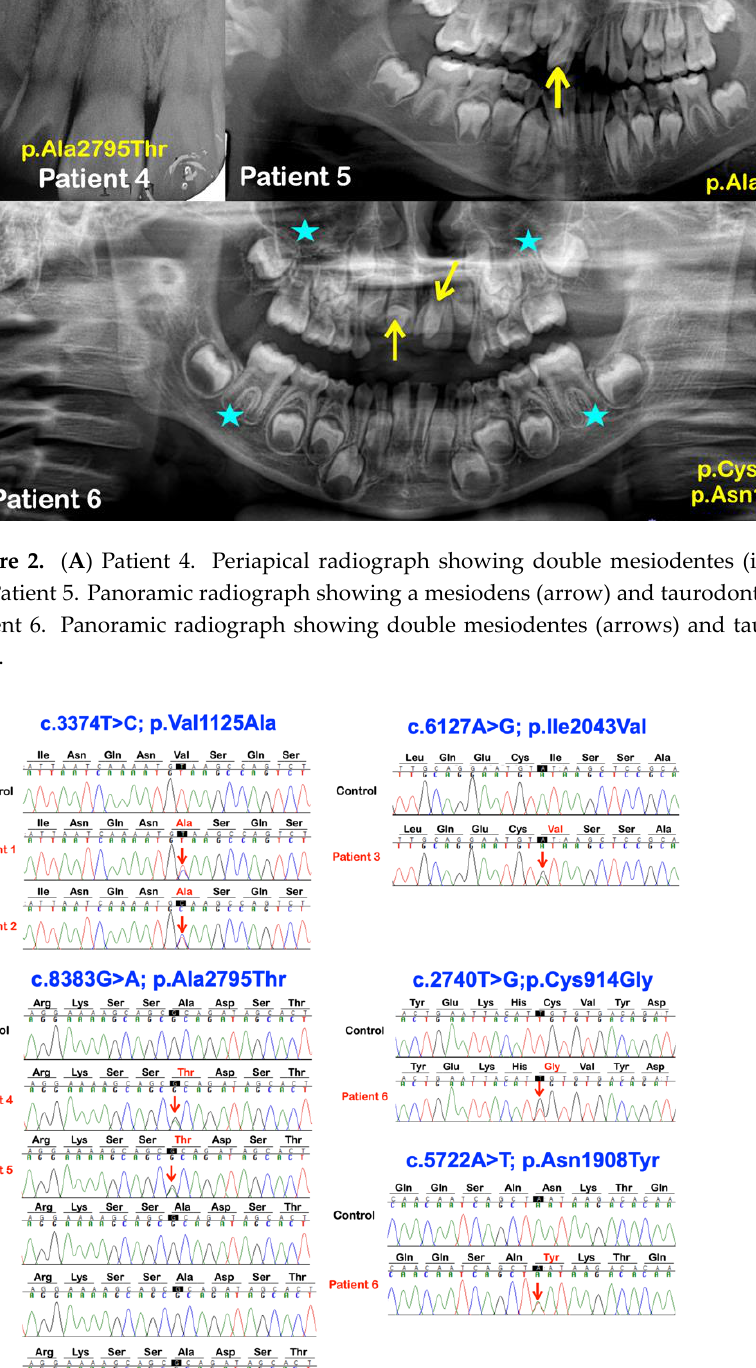
Figure 3. Sequence chromatograms of APC variants in patients 1–6, controls, and their unaffected family members.